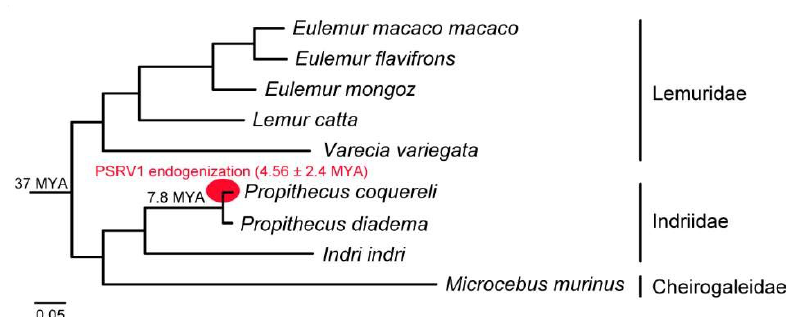
Figure 5. Cladogram of lemur species divergence and PSRV1 endogenization overlay. Estimated time of integration of PSRV1 into P. coquereli genome occurred within 4.56 MYA (± 2.4 MYA) is indicated in red.